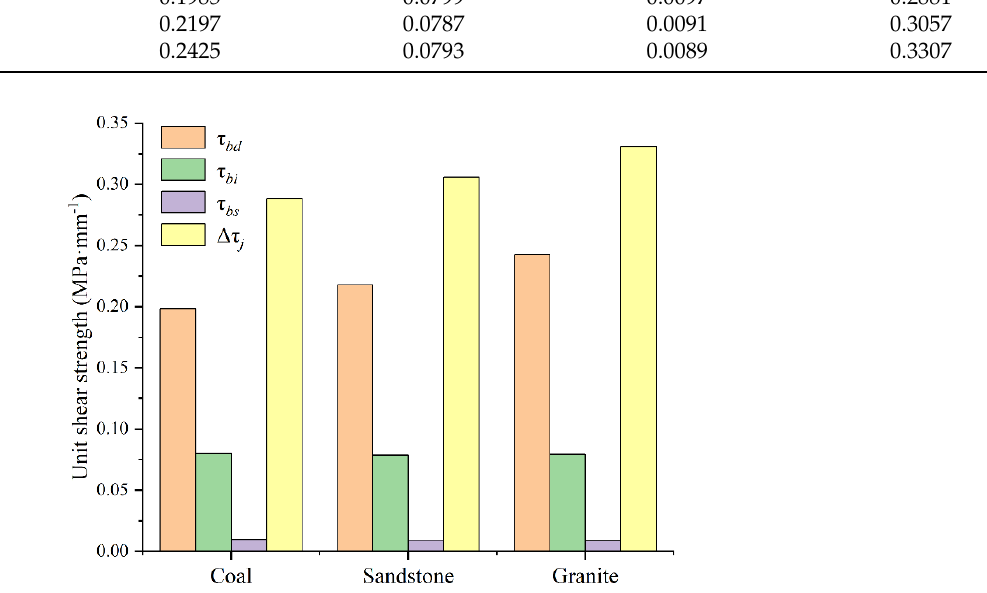
Figure 17. Shear strengths of bolt-reinforced structural surfaces at unit shear displacement.